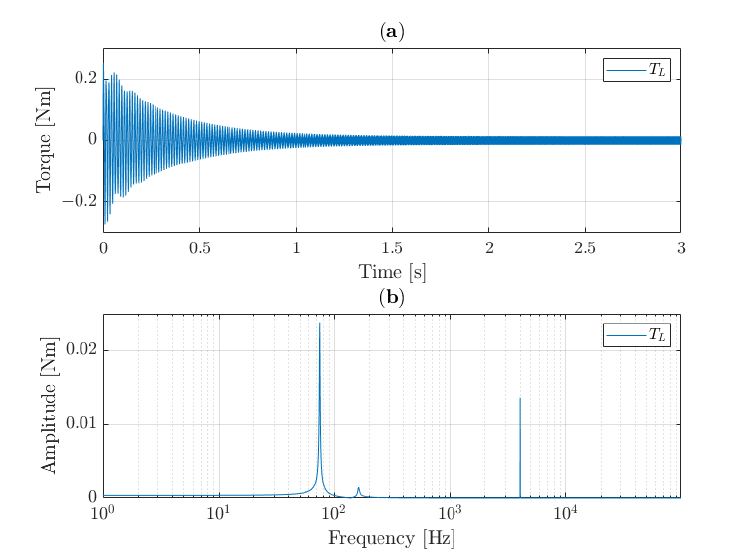
Figure 10. Simulated torque output measured at the load from synchronized sinusoidal torque inputs with pulsation of 4 kHz; ( a ) shows the time domain data and ( b ) shows the signal frequency